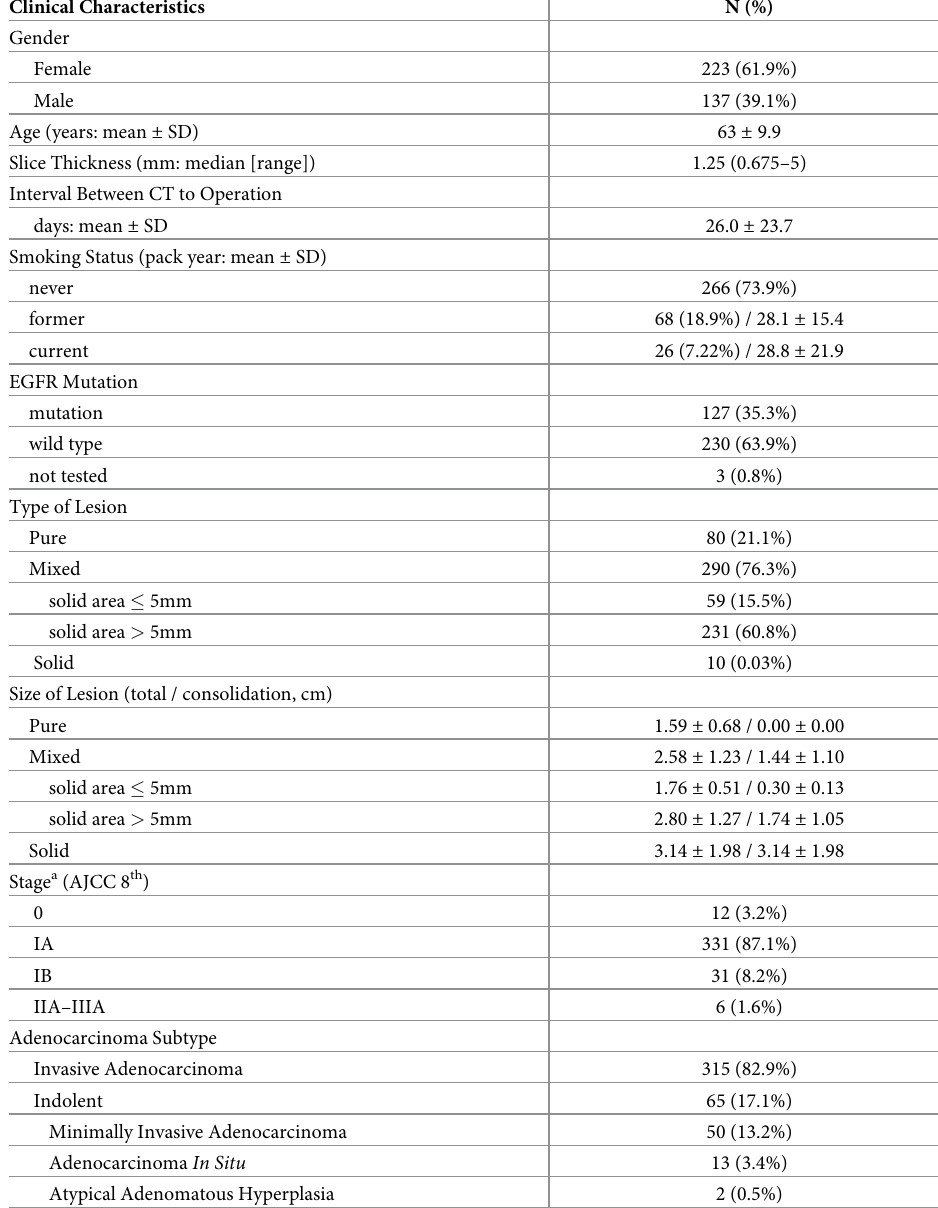
Table 2. Demographic information of 360 patients with 380 ground-glass opacity nodules. Clinical Characteristics